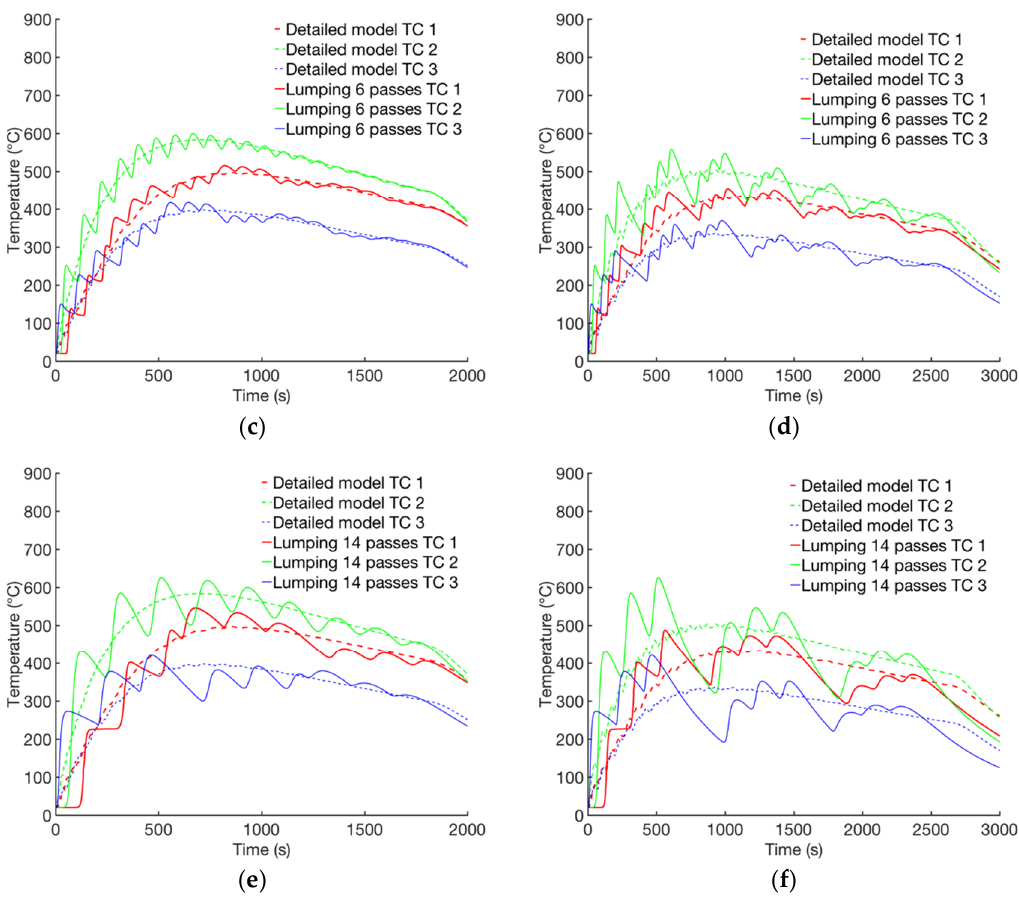
Figure 11. The computed temperatures for the model with fine mesh are compared with those for models with lumping of 3, 6, and 14 passes. The models with no dwell time between layers are shown in ( a ), ( c ) and ( e ) whereas ( b ), ( d ) and ( f ) show the same results for the cases with 20 s dwell time.